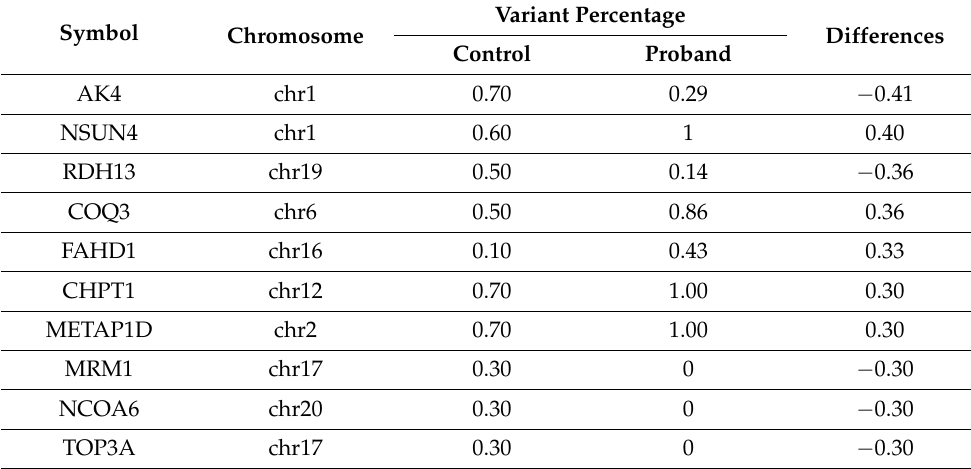
Table 2. Mitochondria-related nuclear genes with aa difference over 0.3 of variant percentage between the proband and control groups.